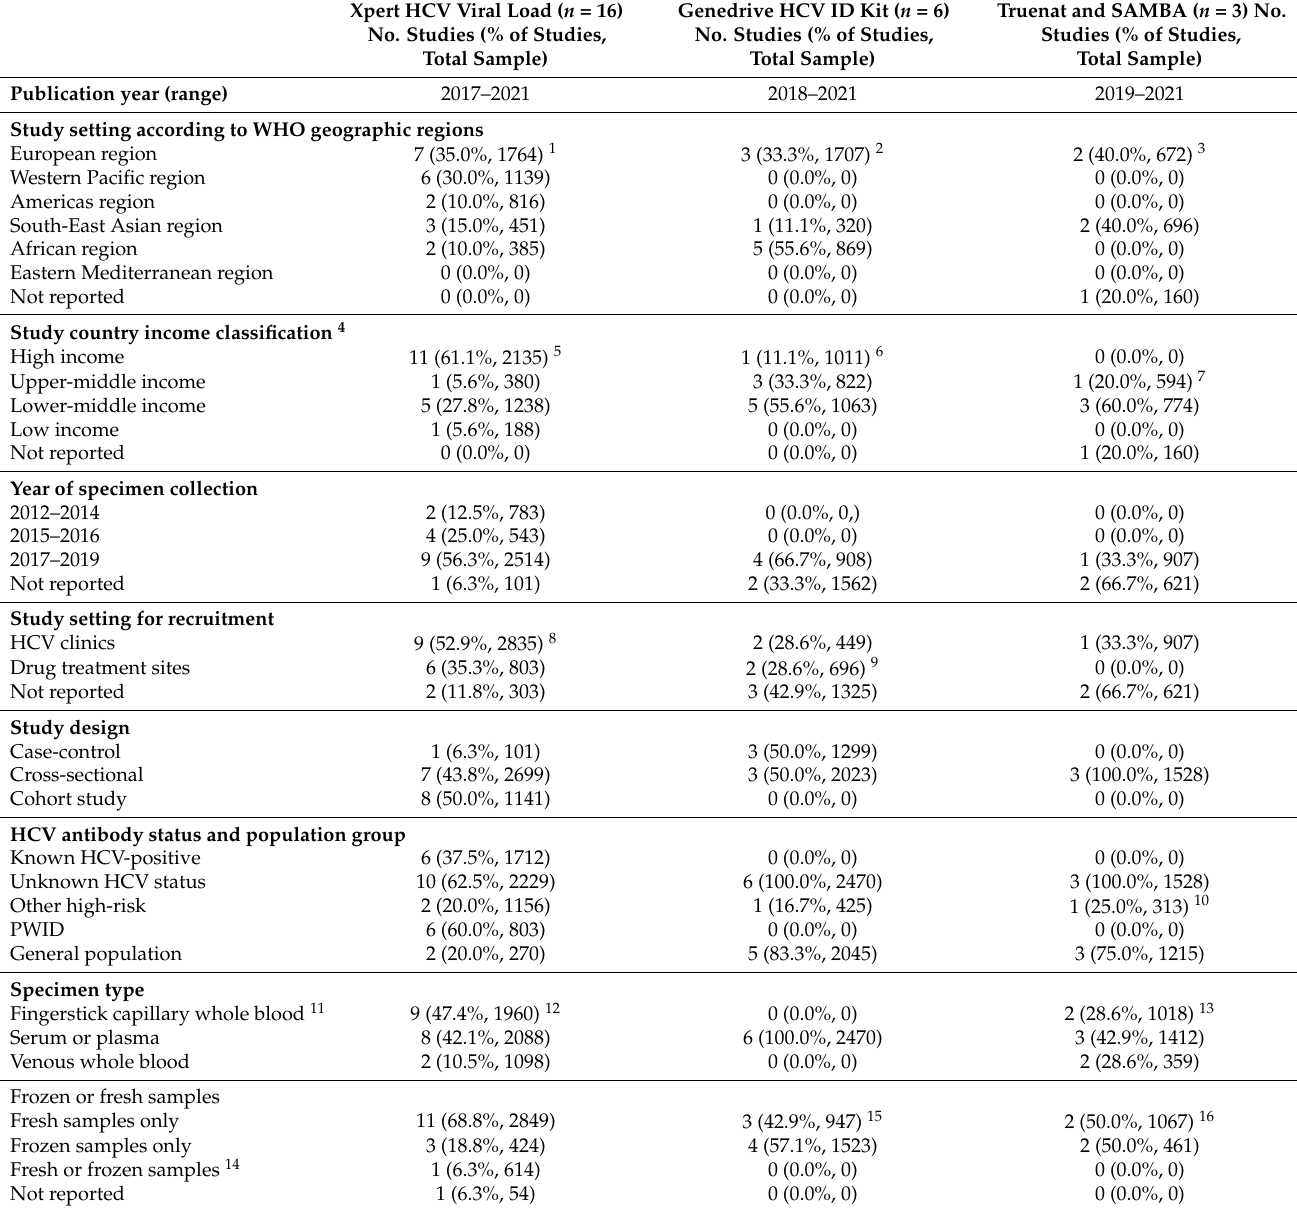
Table 1. Summary of characteristics of the 25 included diagnostic performance studies of PoC HCV viral load assays (Gene Xpert, Genedrive, Truenat, and SAMBA). Xpert HCV Viral Load ( n = 16) No. Studies (% of Studies, Total